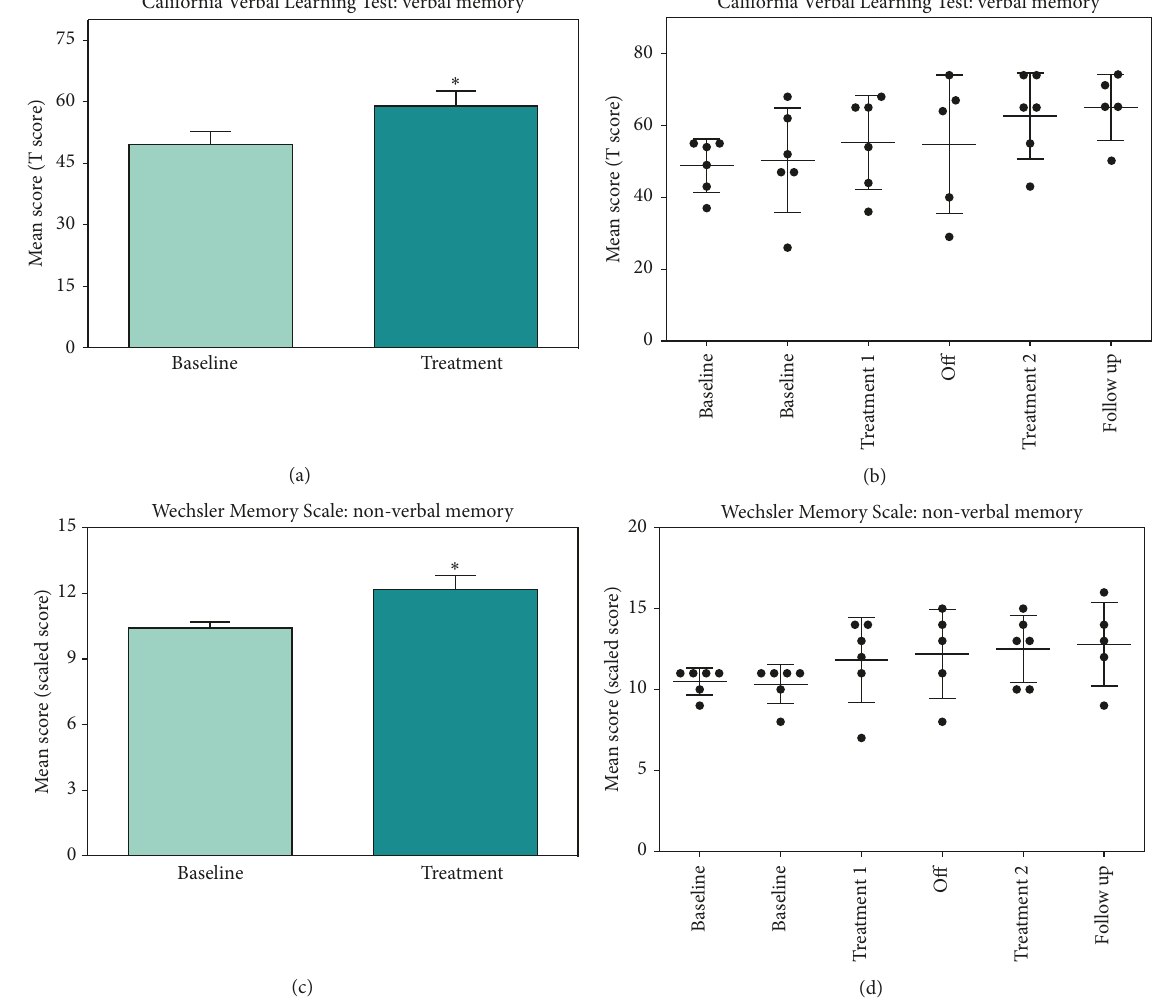
Figure 1: Effect of HBOT on memory: we observed a significant effect of HBOT on verbal and nonverbal memory using the CVLT (a & b), which measures verbal memory, and the WMS (c & d), which measures nonverbal memory. Graphs (a) and (c) represent the difference between baseline and treatment and (b) and (d) show all individual data